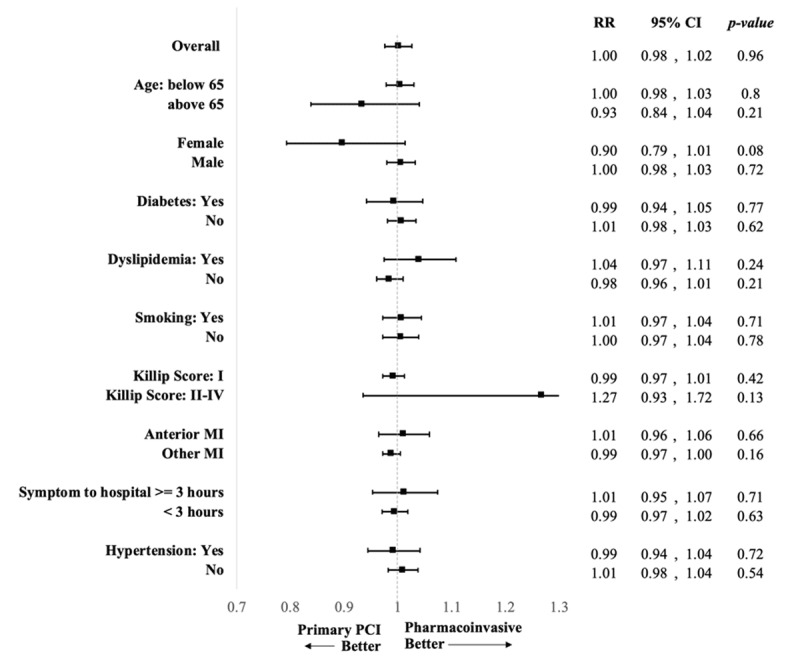
Subgroup analyses for the risk of developing in-hospital composite outcome comparing the two interventions. There was no difference between primary PCI and PhI in terms of in-hospital composite outcome (death, reinfarction, CHF and stroke) in the overall group and subgroup analysis using following categories: age, sex, diabetes, dyslipidemia, smoking status, Killip score, MI location, duration from symptom onset to hospital arrival and hypertension. All models were adjusted for baseline systolic blood pressure, baseline heart rate and baseline BMI.